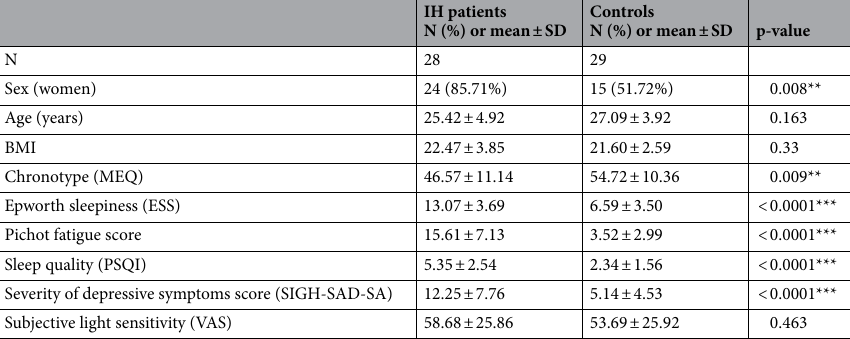
Table 1. Clinical and sociodemographic characteristics of 28 IH patients with Long Sleep Time and 29 Controls. IH hypersomniacs patients with long sleep time, Controls healthy subjects, BMI body mass